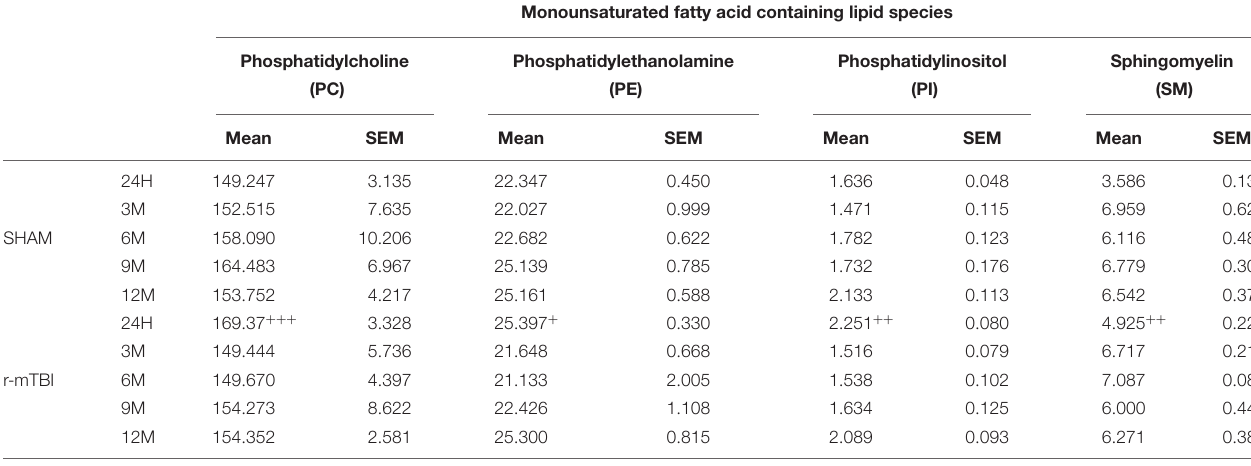
TABLE 3 | Monounsaturated fatty acid containing phospholipid species in the cortex of repetitive mTBI hTau mice.